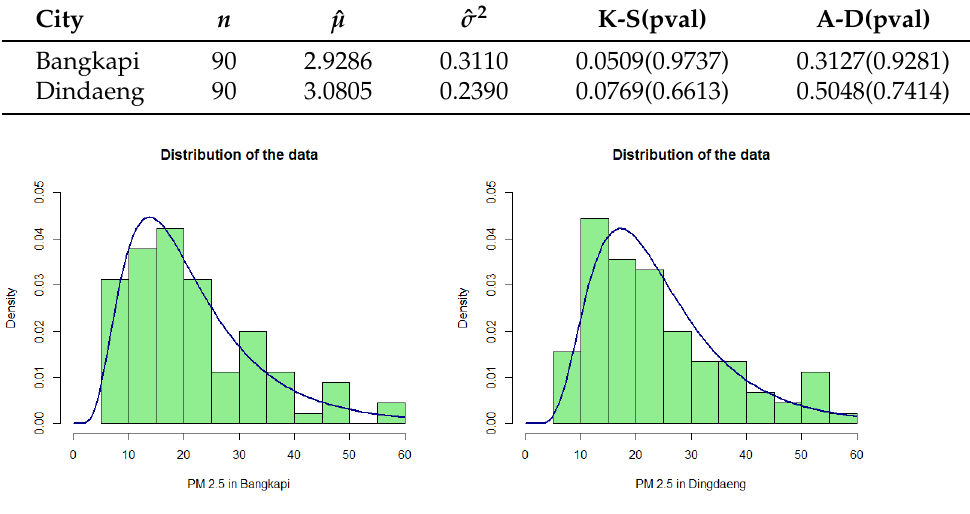
Figure 1. Histogram and PDF fit of PM2.5.